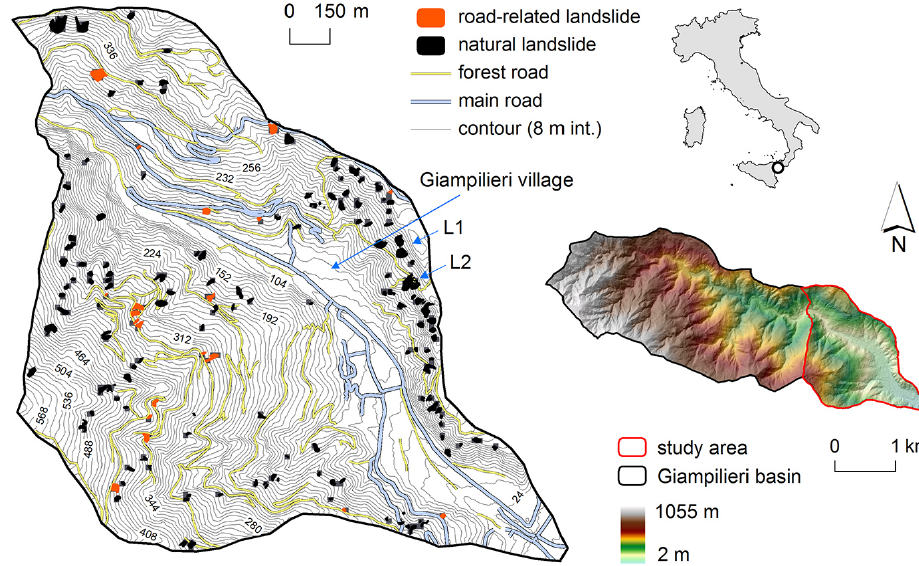
Figure 1. Location map of the study area. Road-related landslides are highlighted in red, while the others are reported in black. The landslides L1 and L2, described as example in Fig. 4, are also reported.